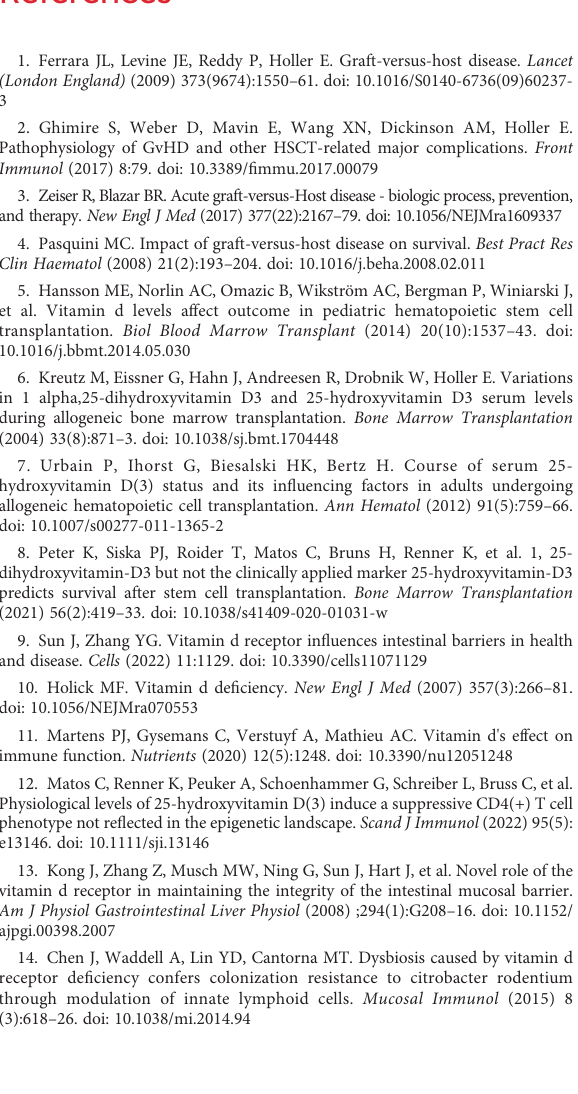
SUPPLEMENTARY TABLE 1 Results from Cox regression analysis for 1-year TRM. Out of the 90 patients, 28 died of TRM, 4 died of RRM and 58 lived until end of 1-year observation period. High-risk group with respective patients numbers are given for categorical variables. HR, hazard ratio; CI, con fi dence interval; MUD, matched unrelated donor. Signi fi cant differences in p values are shown in bold numbers. SUPPLEMENTARY FIGURE 1 Association of VDR gene with the probability of TRM. A. VDR gene expression without and with TRM within 1-year following the biopsy retrieval. Median survival time in no TRM group = 12 months, median survival time in TRM group = 3 months. B. Kaplan-Meier curve showing the probability of TRM in patients with low (red line) or high (green line) VDR gene expression. The time in x-axis refers to the time from obtaining biopsies until the last follow up. Median survival time in VDR low group = 14 months, median survival time in VDR high group = 67 months. Box plots represent median, upper and lower quartile and whiskers indicate minimal and maximal values. p value, Mann-Whitney U test for A and log rank test for